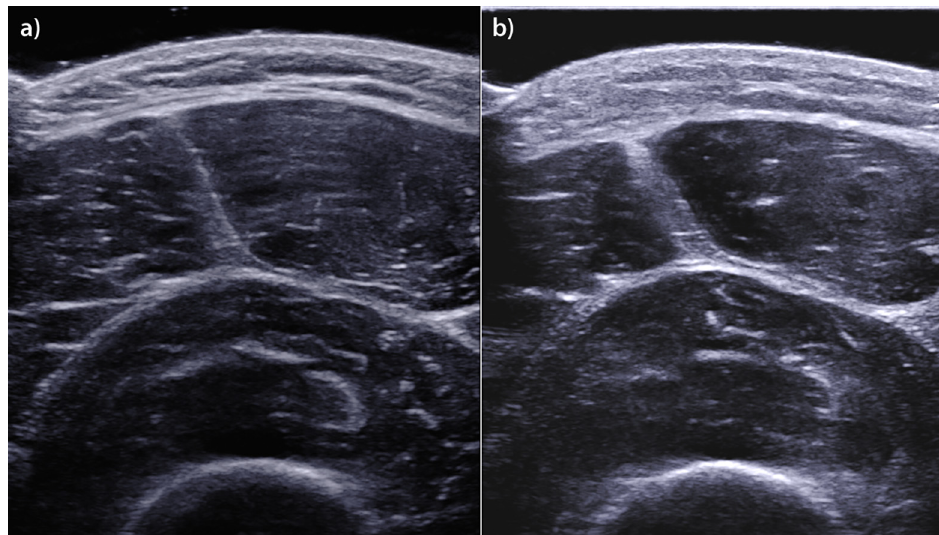
Fig 4. Edematous and architectural thigh muscle changes at the Finish assessment. US images of the quadriceps femoris muscle, which were obtained in the axial plane during the Pre session (a) and the Finish session (b). Note the edematous thickening of the skin and the muscle fascia in the image obtained during the Finish